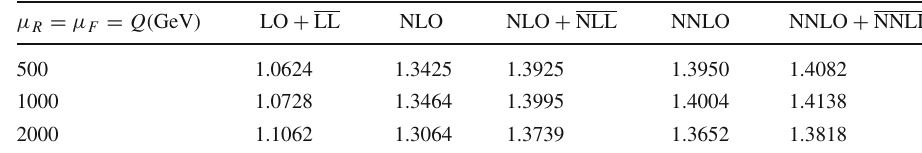
Table 5 The K-factor values for resummed result in comparison to the fixed-order ones